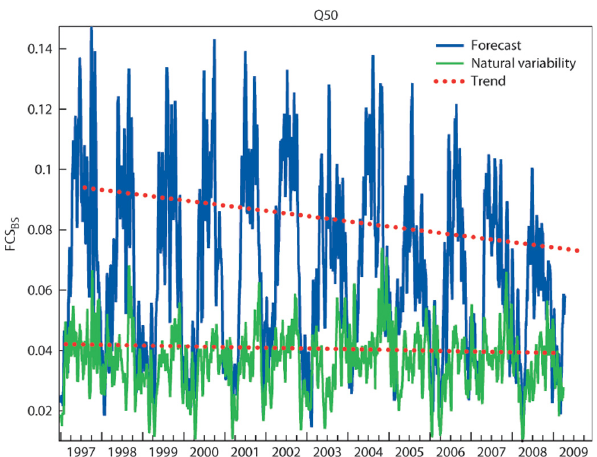
Fig. 1. FCS BS averaged over Europe from 1 January 1997 to 31 April 2009 for the Q 50 threshold comparing forecasts of day 5 and 6. The straigth-dotted lines indicate the trends in the max- ima and minima of this time series. The bottom line shows natural variability.